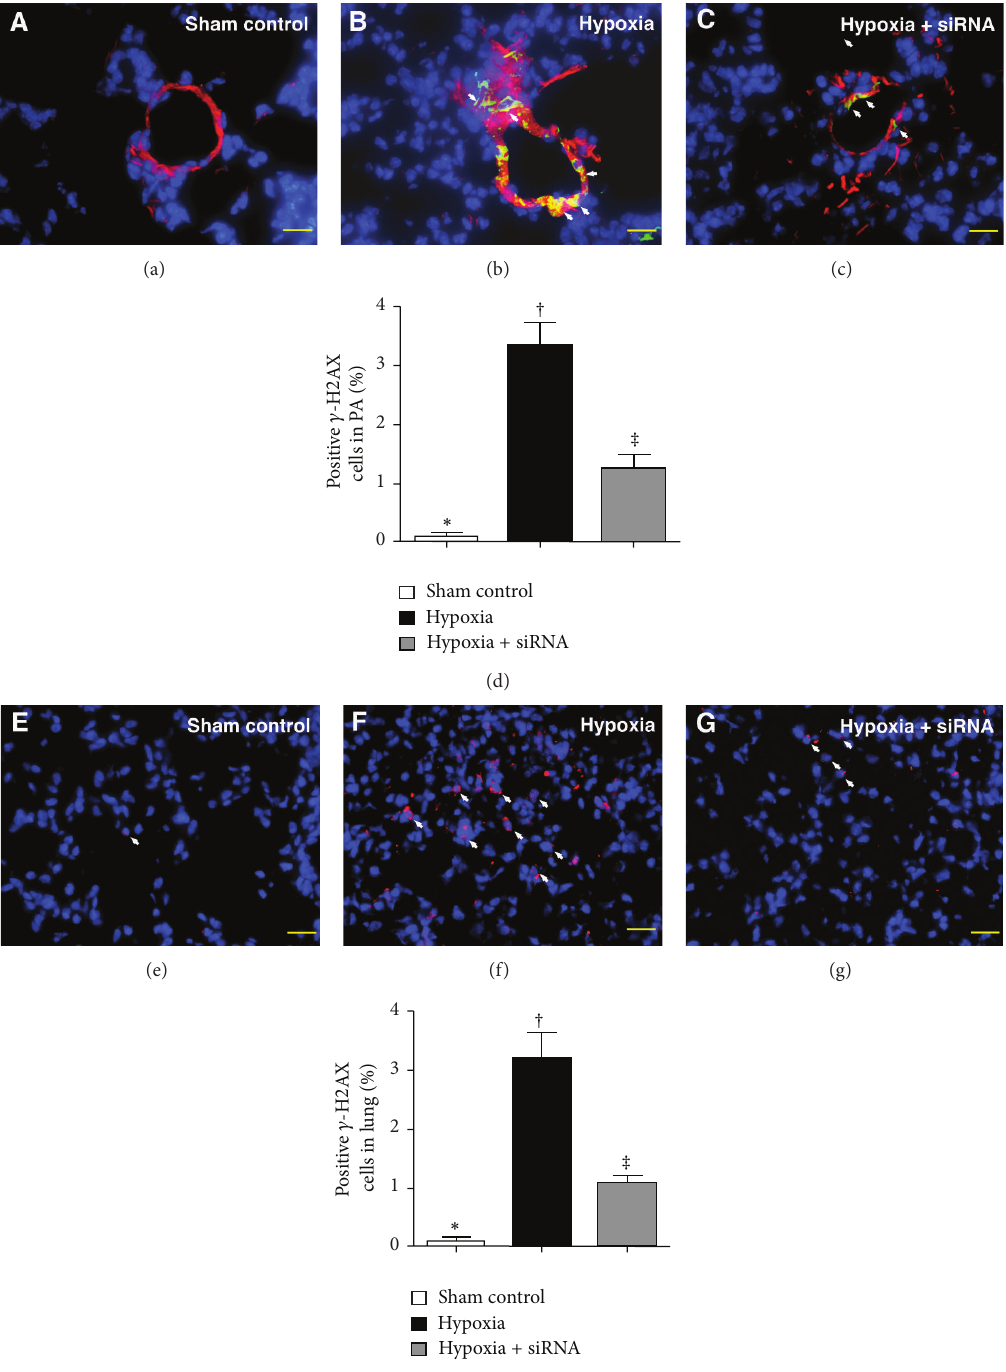
Figure 3: Immunofluorescent (IF) staining for 𝛾 -H2AX+ cells in medial layer of pulmonary arterioles (PA) and lung parenchyma by day 28 after hypoxia-induced pulmonary arterial hypertension (PAH) ( 𝑛 = 10 ). ((a) to (c)) Identification of 𝛾 -H2AX+ cells in PA (white arrow) using IF double staining (i.e., 𝛼 -SMA- 𝛾 -H2AX) in the three groups (400x). (d) ∗ versus other groups with different symbols ( ∗ , † , ‡ ), 𝑃 < 0.0001 . ((e) to (g)) Identification of 𝛾 -H2AX+ cells in lung parenchyma (white arrow) with IF double staining (i.e., 𝛼 -SMA- 𝛾 -H2AX) in the three groups (400x). (h) ∗ versus other groups with different symbols ( ∗ , † , ‡ ), 𝑃 < 0.0001 . The scale bars in right lower corners represent 20 𝜇 m. Blue fluorescence indicates DAPI-stained nuclei. Statistical analysis in (d) and (h) using one-way ANOVA, followed by Bonferroni multiple comparison post hoc test. Symbols ( ∗ , † , ‡ ) indicate significance (at 0.05